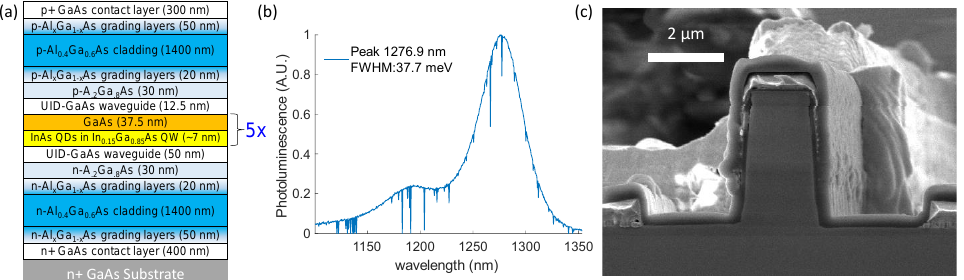
Figure 2. ( a ) Schematic and ( b ) photoluminescence of the epitaxial stack. ( c ) Scanning electron microscope image of a fabricated